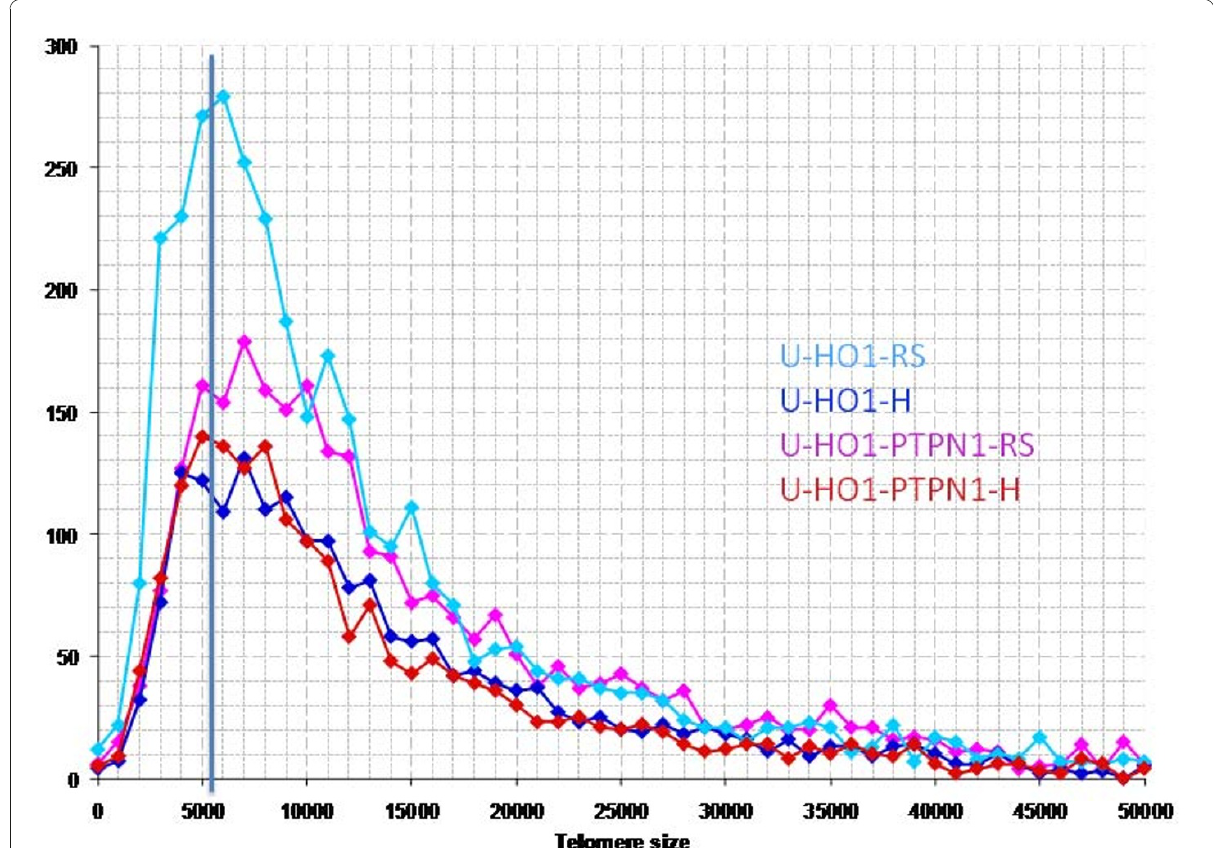
Figure 5 Telomere distribution according to size in U-HO1 and U-HO1-PTPN1 . Results are based on 3D analysis of at least 30 H-cells and at least 30 bi- or multinucleated RS cells. Grey line at 5000 U demarcates the border between very short telomeres including “ t-stumps ” and short telomeres. U-HO1 RS-cells (clear blue) show significantly more (p < 0.0001) very short telomeres (0-5000 units) compared to U-HO1-PTPN1 RS- cells (pink). U-HO1-PTPN1 RS-cells have nearly identical numbers of very short telomeres as U-HO1-PTPN1 H-cells consistent with the possibility that PTPN1 expression abolished the formation very short telomeres including “ t-stumps ” during the transition from H- to